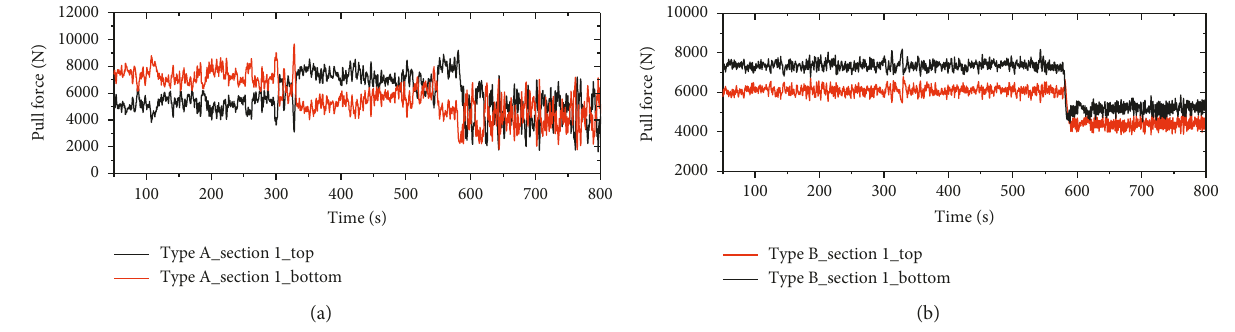
Figure 9: Pull forces on the top and bottom surfaces of two different kinds of pull rods. (a) Type A. (b) Type B.